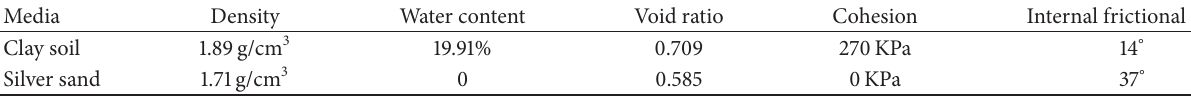
Table 3: Properties of the penetrating and anchoring media.